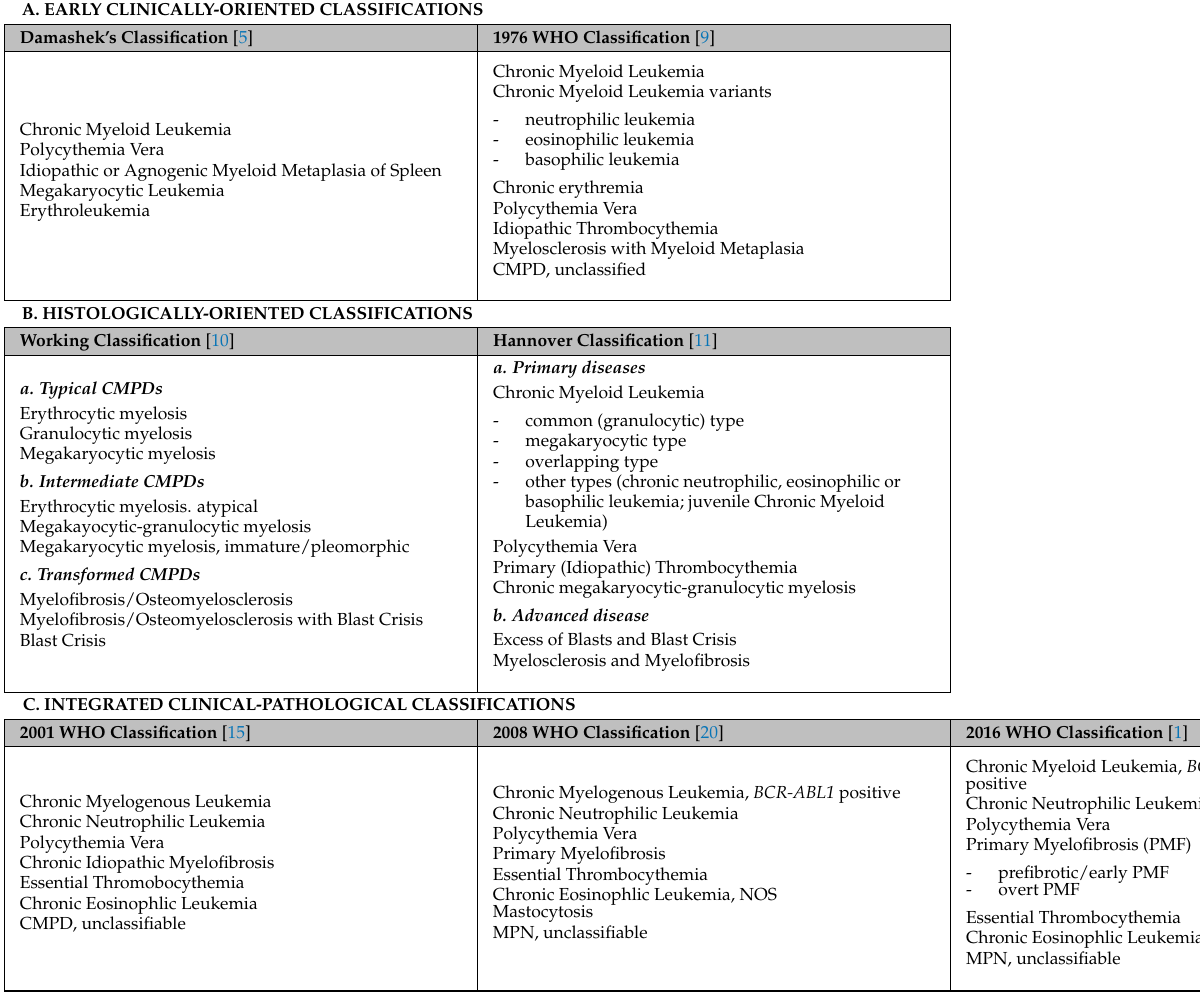
Table 1. Evolution of the Classification of